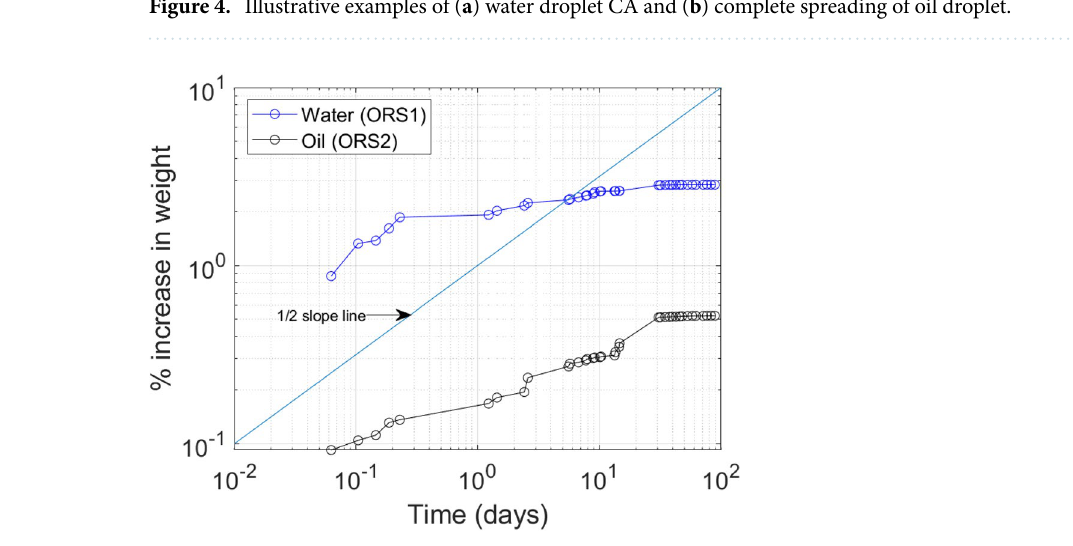
Figure 5. Water and oil uptake (normalized to initial sample weight) in ORS1 and